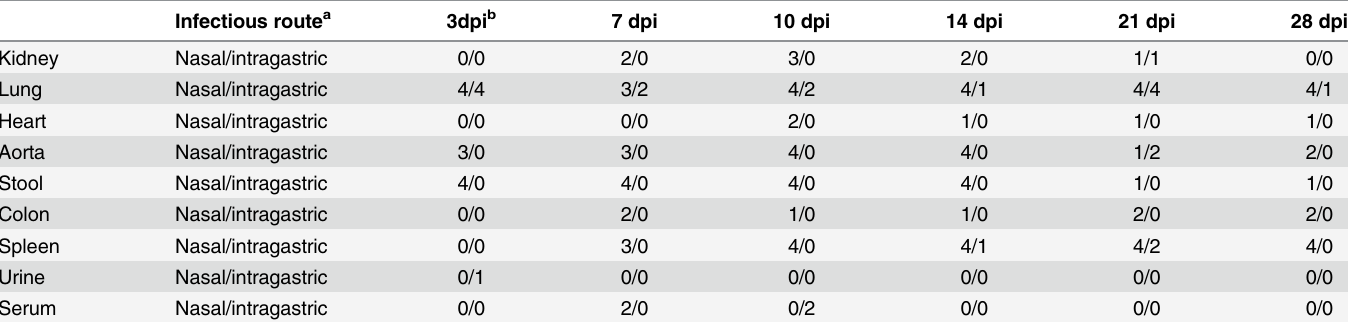
Table 2. Frequency of Detectable Viral DNA in Different Organs after Groups of 4 mice were Infected by the Nasal or Intragastric Route. Infectious route